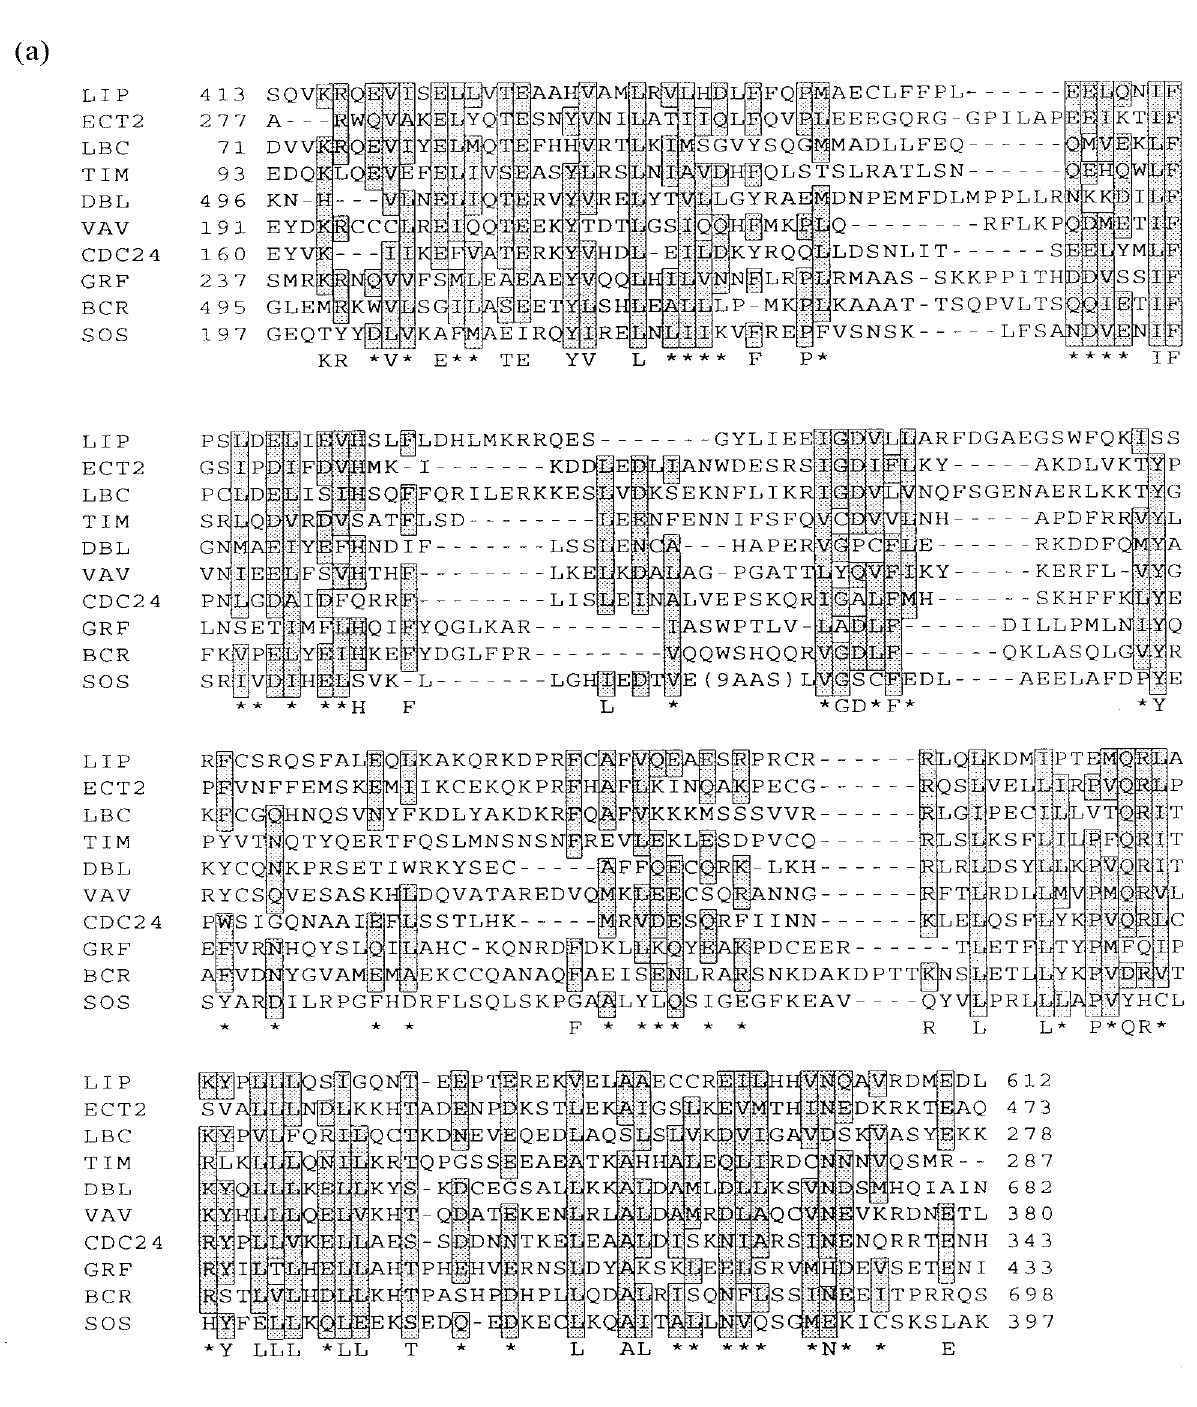
Fig. 3. (a) Computer-generated alignment of the DH domain in LIP, ECT-2, LBC, TIM, DBL, VAV, CDC24, p140RASGRF, BCR and murine SOS using the Clustal V programme. The consensus sequence is indicated below. A capital letter indicates six or more of the proteins possess an identical amino acid at this position, and an asterisk that the amino acid is conserved in six or more of the proteins. Amino acids are numbered on the left. Sequences were obtained from the GENBANK database via Northwick Park Hospital, Middlesex, UK. (b) Alignment of pleckstrin N, pleckstrin C with LIP, VAV, DBL, CDC24, ECT-2, p140RASGRF, BCR and SOS, over the PH domain. The proteins were aligned as previously described. 30 The conserved amino acid residues which anchor the ® ve previously described subdomains 24 are shown in capitals below the alignment, with additional conserved residues marked with an asterisk.